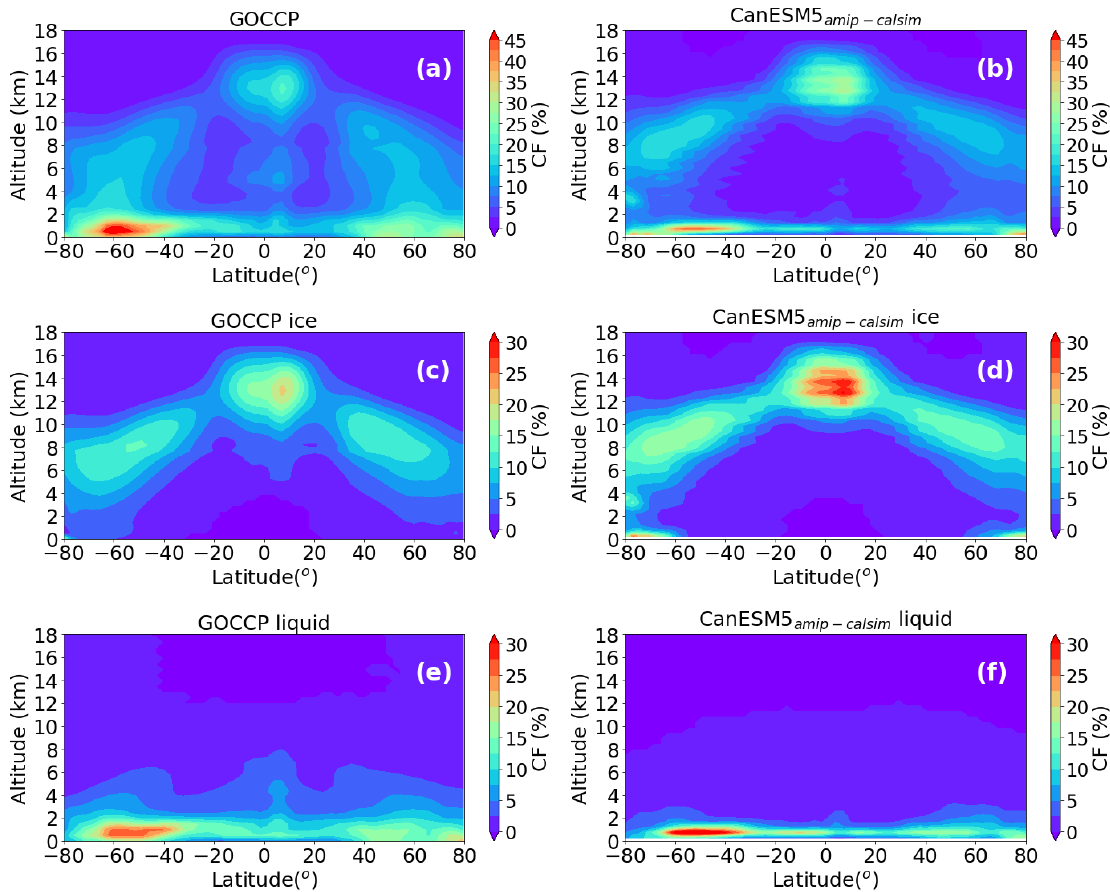
Figure 9. Annually and zonally average vertical cross-section of CF GOCCP (all phase ( a ), ice ( c ), liquid ( e )) and CanESM5 amip−calsim (all phase ( b ), ice ( d ), and liquid ( f )).